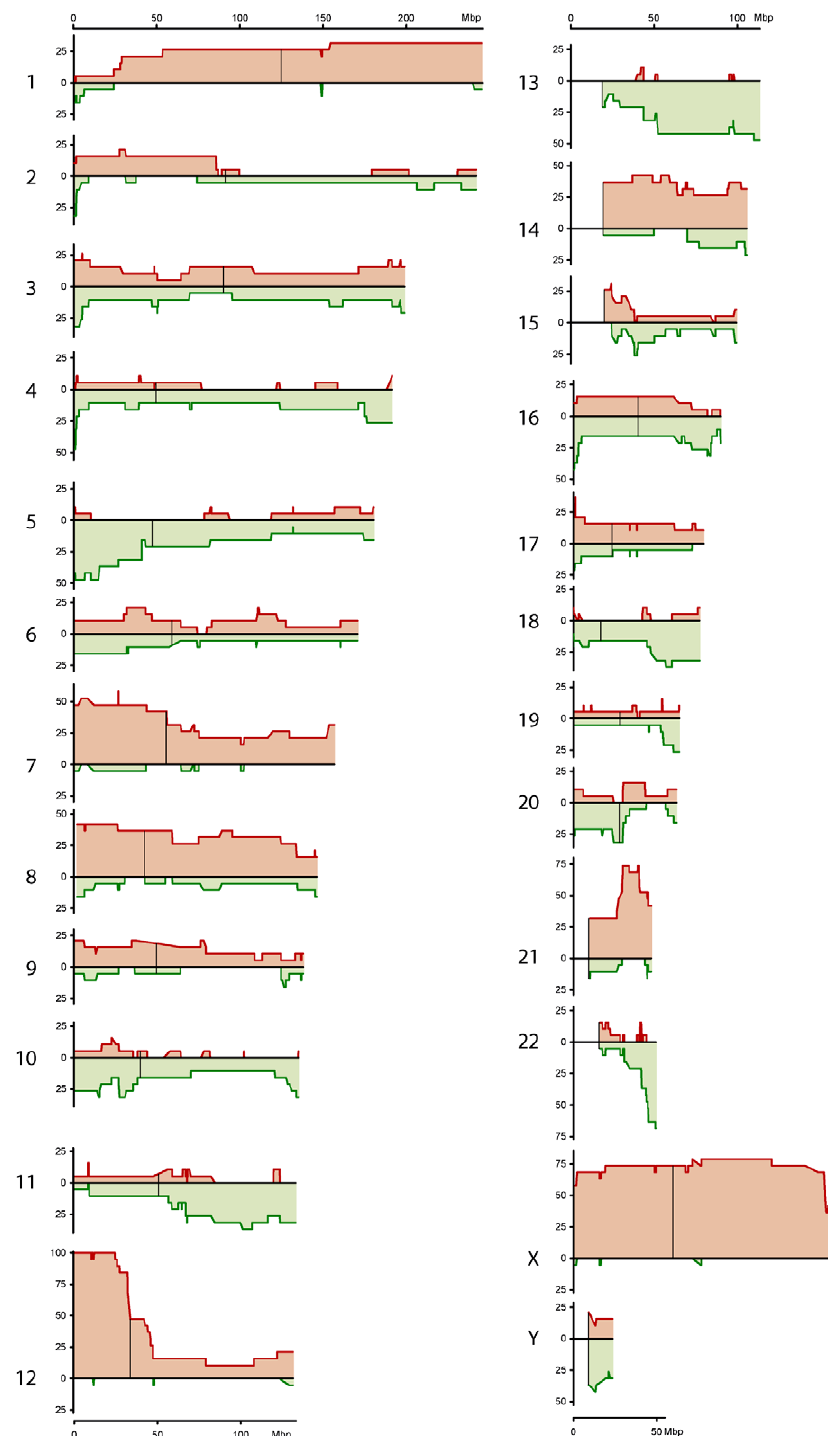
Fig. 1. The testicular germ cell tumor genome. Percentages of DNA copy number gains (red) and losses (green) from 19 testicular malignancies (17 TGCTs and 2 TGCT cell lines) are shown. Vertical black lines indicate centromere